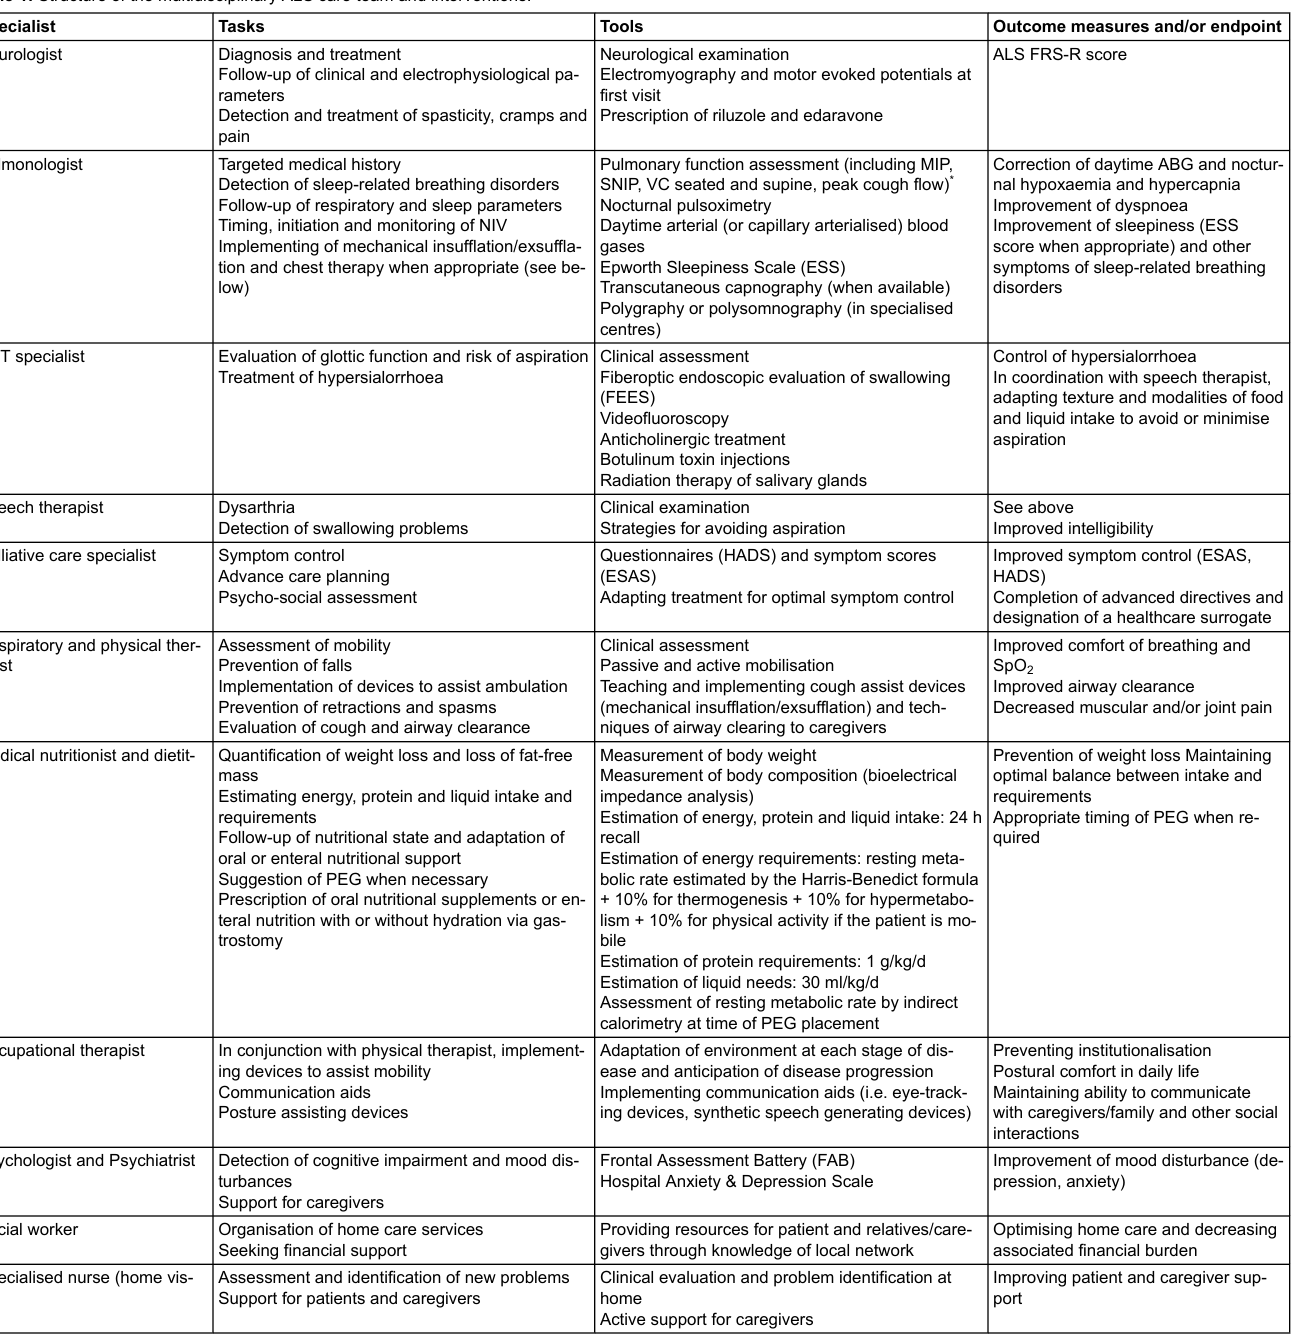
Table 1: Structure of the multidisciplinary ALS care team and interventions.